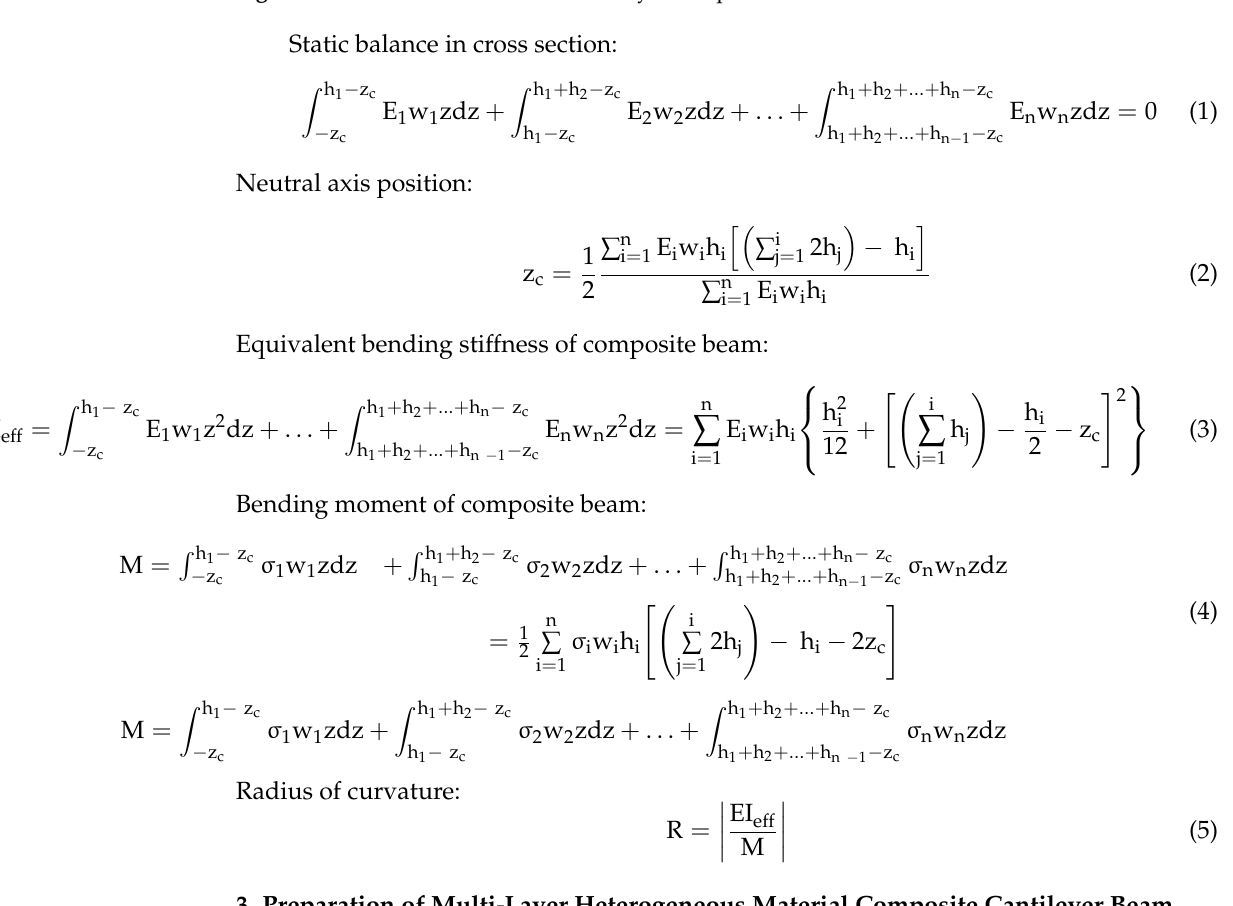
Figure 1. Theoretical model of a multi-layer composite cantilever beam.